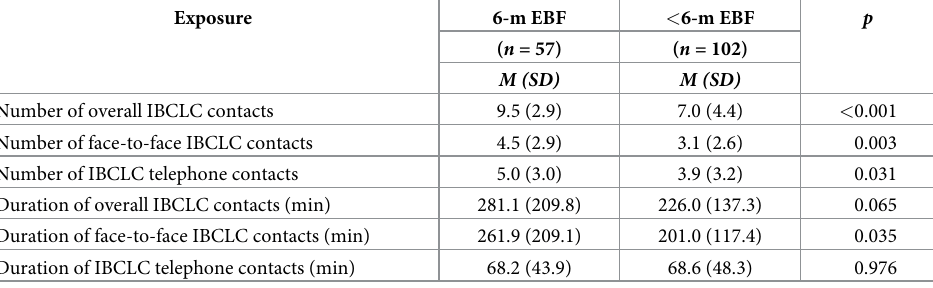
Table 3. Bivariate analysis of the association between six-month EBF and different exposures ( N = 159).